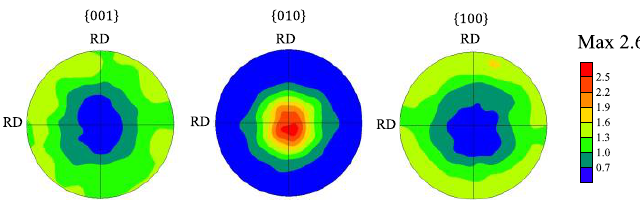
Figure 7 . Pole figures of the compressed sample obtained by the EBSD.